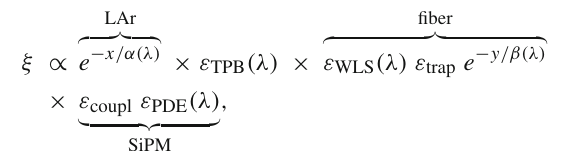
to detect the LAr scintillation light that emerges from in and aroundtheHPGedetectorarray.Ifweneglectmostgeometric effects, the photon detection probability can be broken down into factors that depend on basic properties of the materials and components involved. Given a primary photon that is emitted in the system LAr-TPB-fiber-SiPM, as depicted in Fig. 2, the probability ξ for its detection, can be described